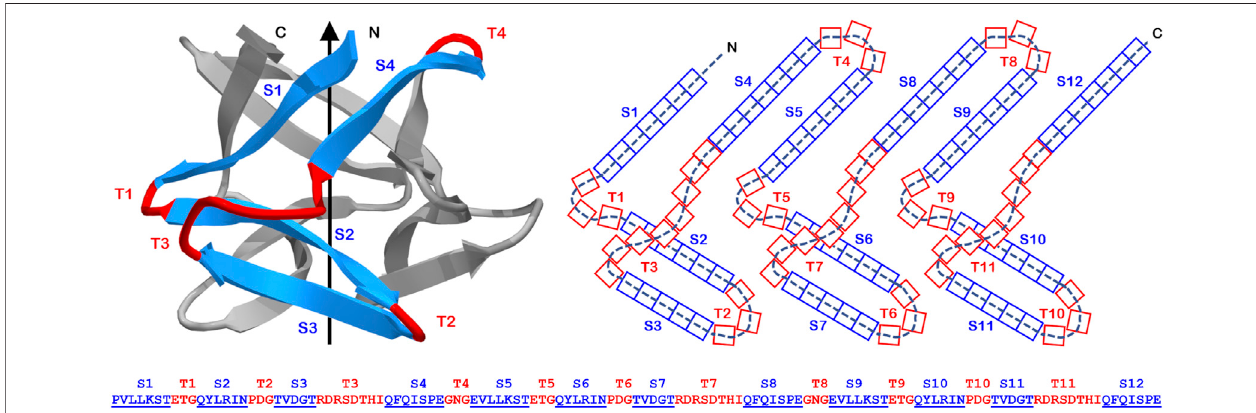
FIGURE 1 | The primary, secondary, and tertiary structure of the Symfoil ( “ Symfoil-4T ” ) reference β -trefoil protein. Upper panel: A “ ribbon ” diagram of the Symfoil protein (RCSB 3O4B). The colored region (blue: β -strand; red: turn) identi fi es the fi rst of three repeating “ trefoil ” motifs in the structure (the other two colored in gray). Middlepanel:Atwo-dimensionalrepresentation oftheoverall β -trefoilarchitecture andindicatingthestrandandturnnumberingandthenumberofresiduesineachtype of secondary structure (referencing Symfoil). Lower panel: the primary structure of the Symfoil protein indicating the secondary structure positions ( β -strands underlined and indicated by “ S ” , and turns indicated by “ T ” ).